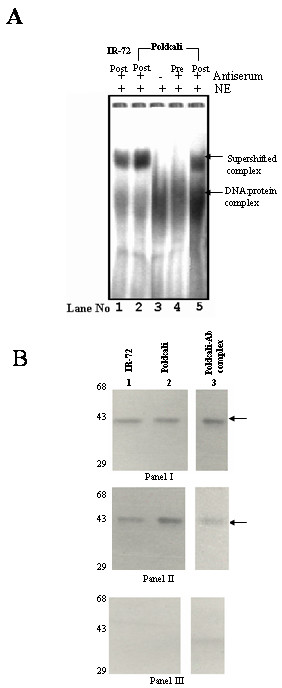
Antiserum against unique region of OSBZ8 factor recognizes OSBZ8 from the ABRE-EMSA complex by either causing supershift or in western analysis after elution of the EMSA complex from the dried gel. A. The nuclear extracts from IR-72 (lane 1) and Pokkali (lane 2 to 5) were incubated with the purified antibody before and after the addition of the probe. Super shift was only detected in post-incubation of the antiserum (lane 1, 2 and 5) and not in pre-incubation (lane 4). In lane 3, antiserum was not added. B. Western blot analysis of protein extracted from dried gel with shifted complex shown in fig. 3A. The nuclear factor was eluted from the [32P]ABRE: protein complex or [32P]ABRE: protein: Ab complex from dried native polyacrylamide gel. It was analyzed by silver staining (IR-72 in Lane 1; Pokkali in Lane 2 and Pokkali-Ab complex in Lane 3, Panel I); recognition by the antiserum against N-terminal end of OSBZ8 (38-kD) factor (Panel II) but not by the preimmune serum (Panel III) after SDS-PAGE.